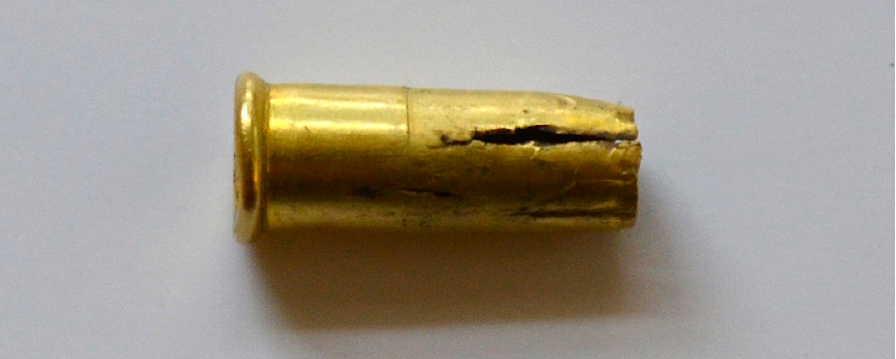
Figure 19. Case splitting in an AS head stamped 0.22 ″ calibre cartridge.